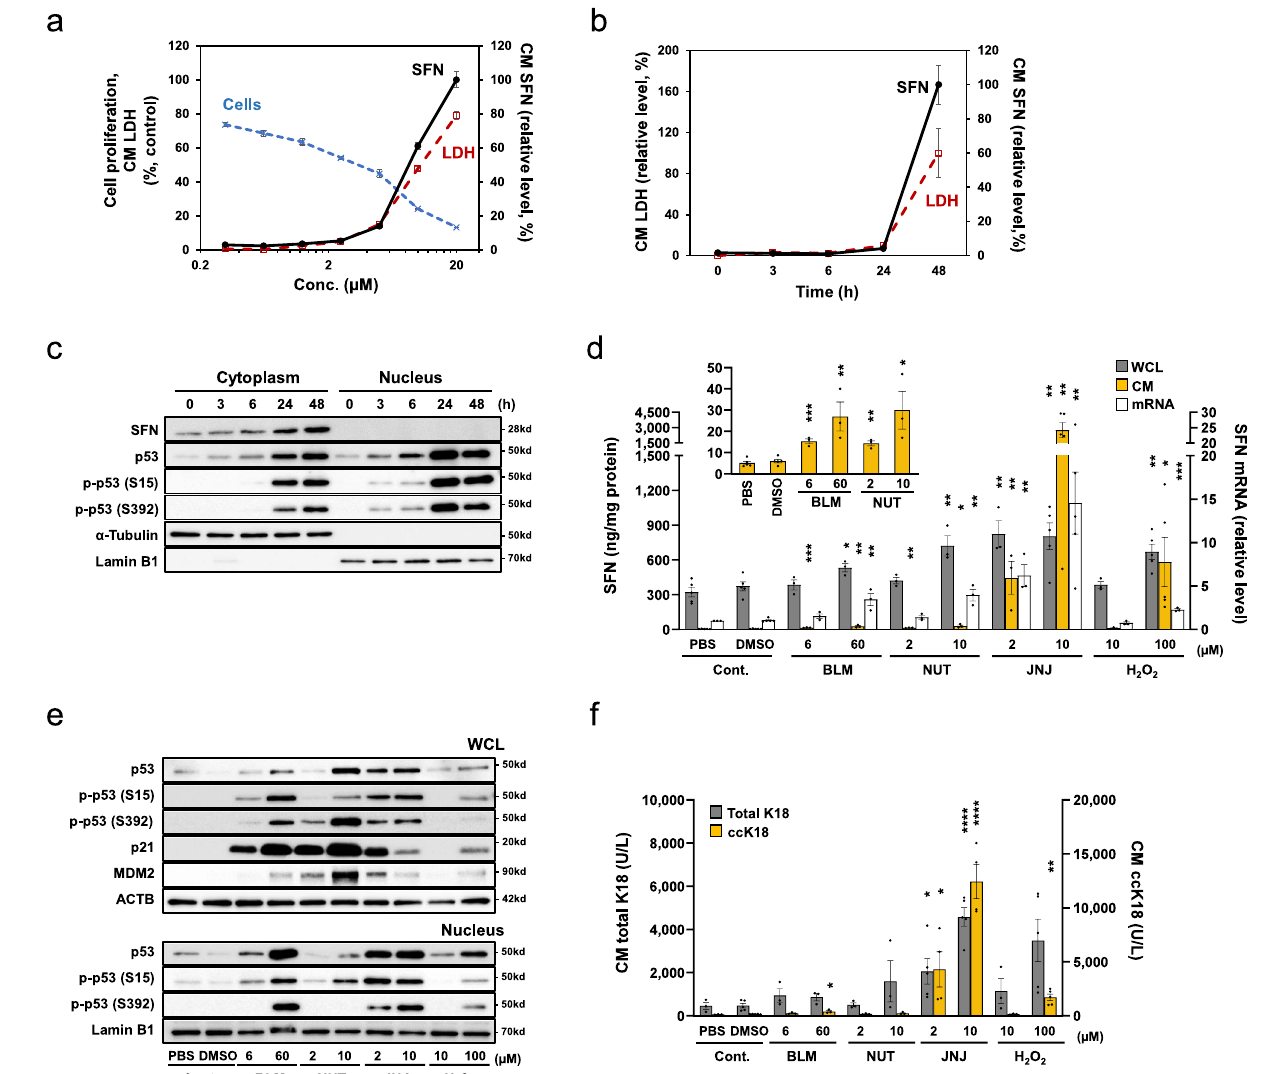
Fig. 6 | Expression and extracellular release of SFN in vitro. a Dose-dependent SFNreleasebyJNJ26854165treatment.VariousconcentrationsofJNJ26854165(JNJ) wereaddedto theA549cells.After48h,thecellproliferationandthe levelsofSFN and LDH released into the conditioned medium (CM) were measured. b , c Time- dependent SFN expression/release and nucleartranslocation ofp53inresponse to JNJ. The A549 cells were treated with JNJ (10 μ M). b At the indicated time points afterthetreatment,theCMwassubjectedtoSFNELISAandLDHassay. c Cellswere collectedandthenfractionatedintocytoplasmicandnuclearfractions,followedby Western blot analysis using the indicated antibodies. Anti α -tubulin and lamin B antibodies were used as a loading control of cytoplasmic and nuclear proteins, respectively. p-: phosphorylated at the amino acid number in parenthesis. d – f Comparison of the expression levels of SFN and p53-related proteins after treatment with various agents. The A549 cells were treated with the indicated